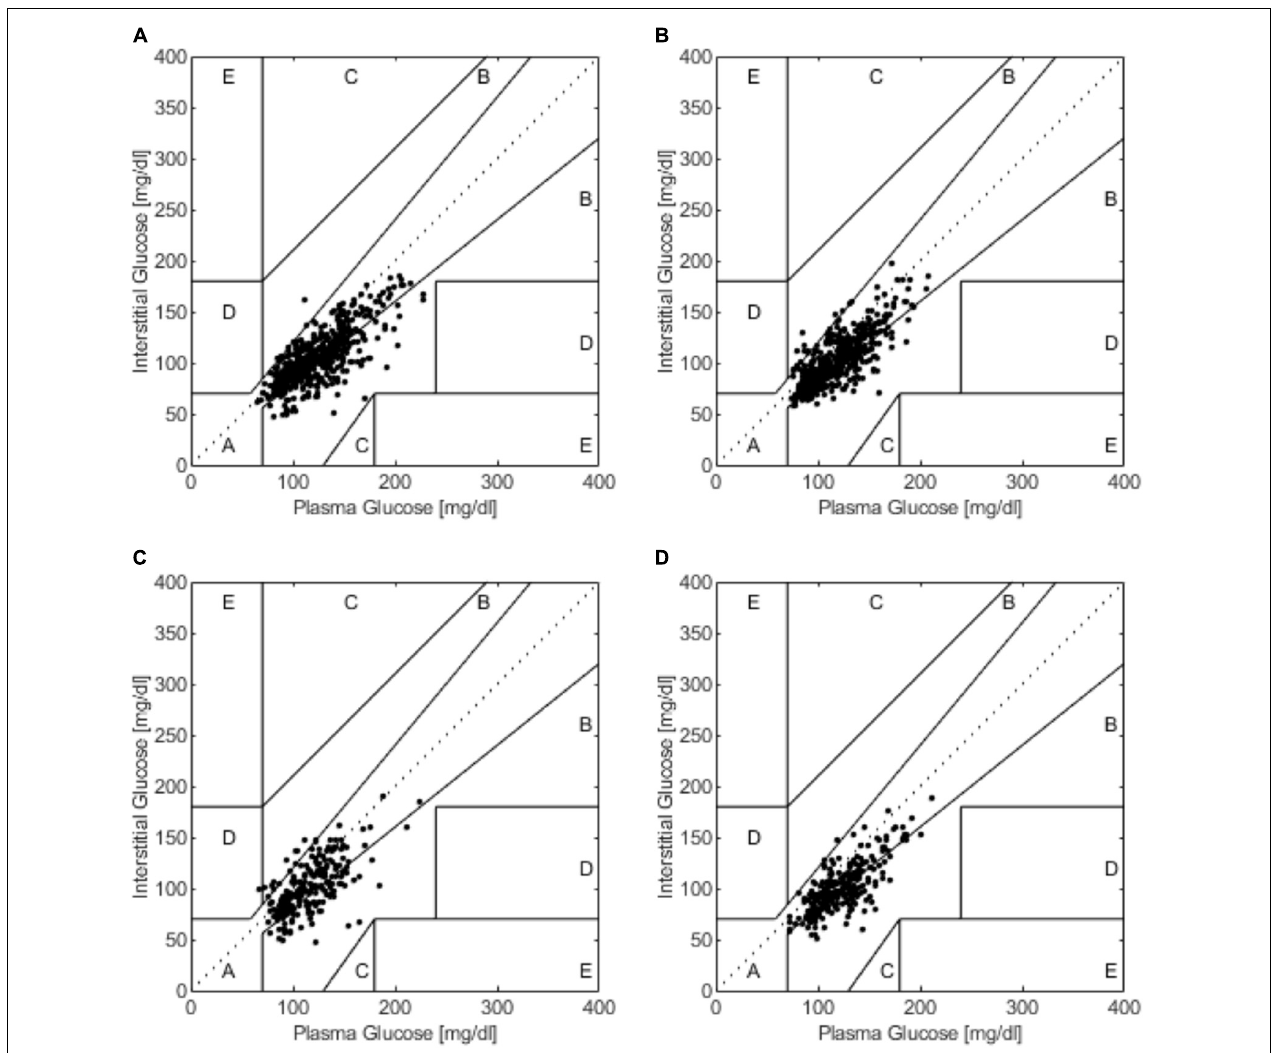
FIGURE 4 | The Clarke error grid analysis during (A) SIT, (B) 20iP + CONT, (C) iP + CONT, and (D) 20iP + ACCU. SIT, sitting. 20iP + CONT: walking continuously for 30 min initiated 20 min before each participant’s postprandial glucose peak (PPGP); iP + CONT: walking continuously for 30 min initiated at PPGP; and 20iP + ACCU: walking accumulated for 30 min initiated 20 min before PPGP (three bouts of 10 min walking separated by 20 min of